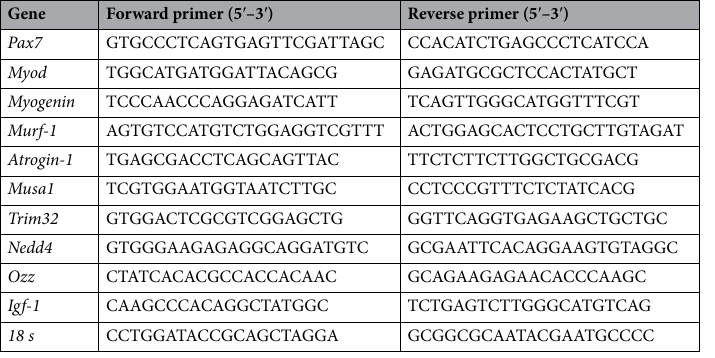
Table 1. Primer sequences for